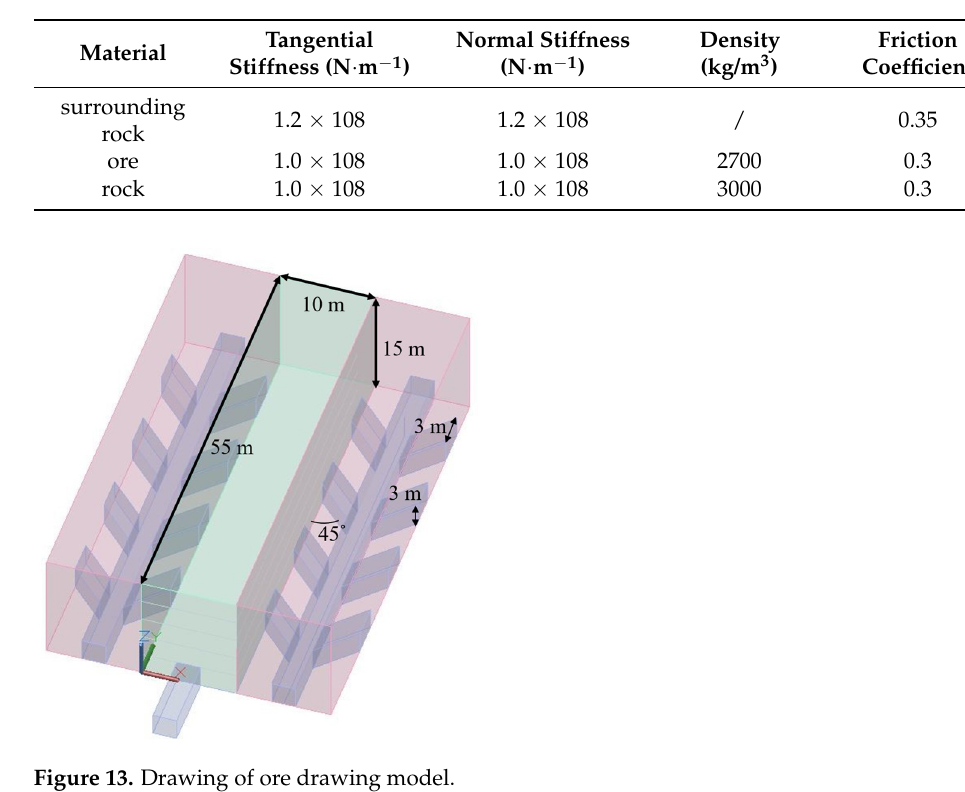
Table 3. Parameter table of numerical simulation.